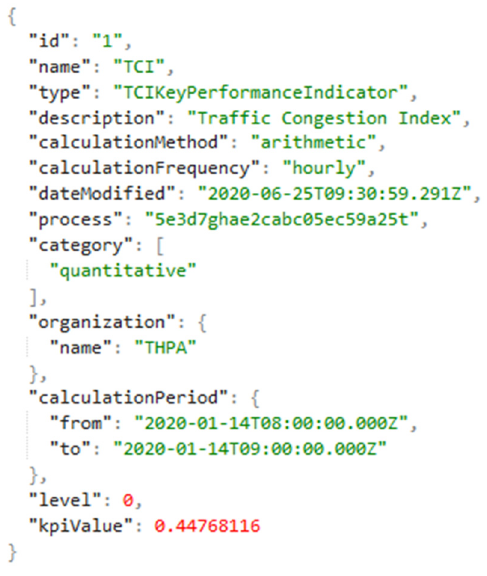
Figure A2. Example of an output KPI generated by the TCI.